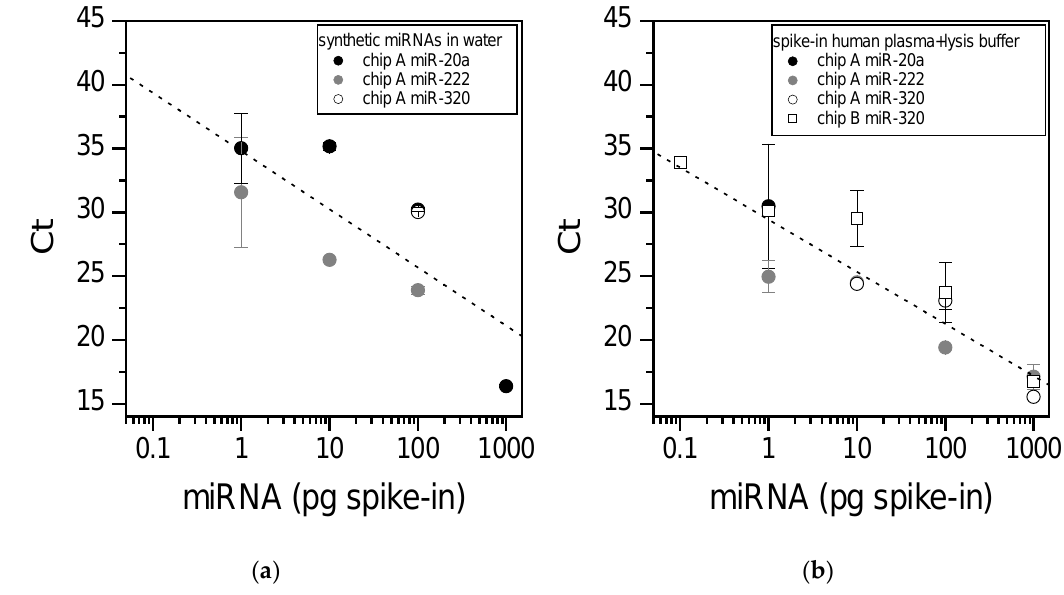
Figure 9 . RT-qPCR results expressed as threshold cycles (Ct) measured when different amounts of synthetic microRNA were spiked in water (Panel ( a )) or in blood plasma (Panel ( b )). The absorbed microRNA was reverse transcribed directly on-chip, while the cDNA products were amplified in standard conditions. A dotted line, from a logarithmic fit of all data is also shown.